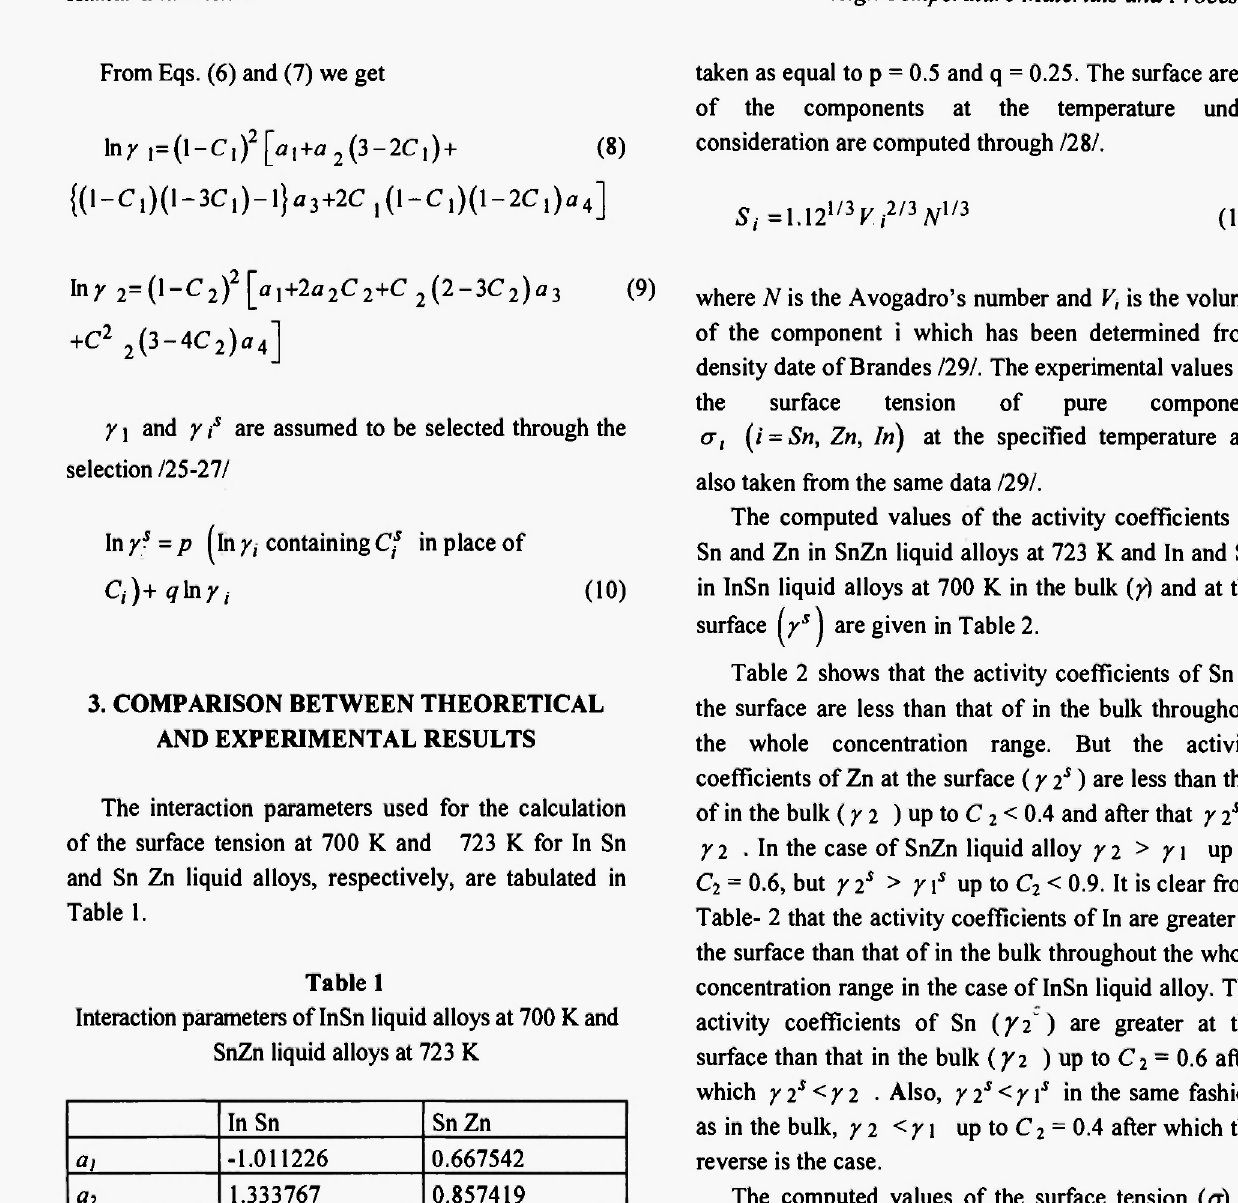
Interaction parameters of InSn liquid alloys at 700 Κ and SnZn liquid alloys at 723